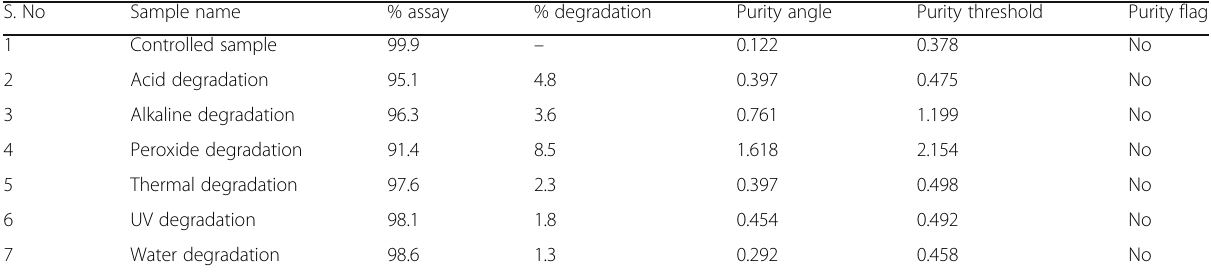
Table 11 Forced degradation study results for dolutegravir S.